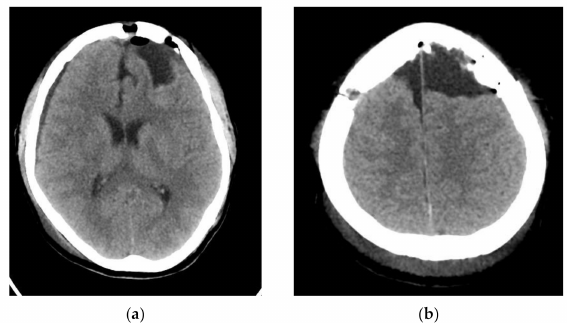
Figure 7. Native head CT Scan 24 h after surgery. ( a , b ) axial slices.